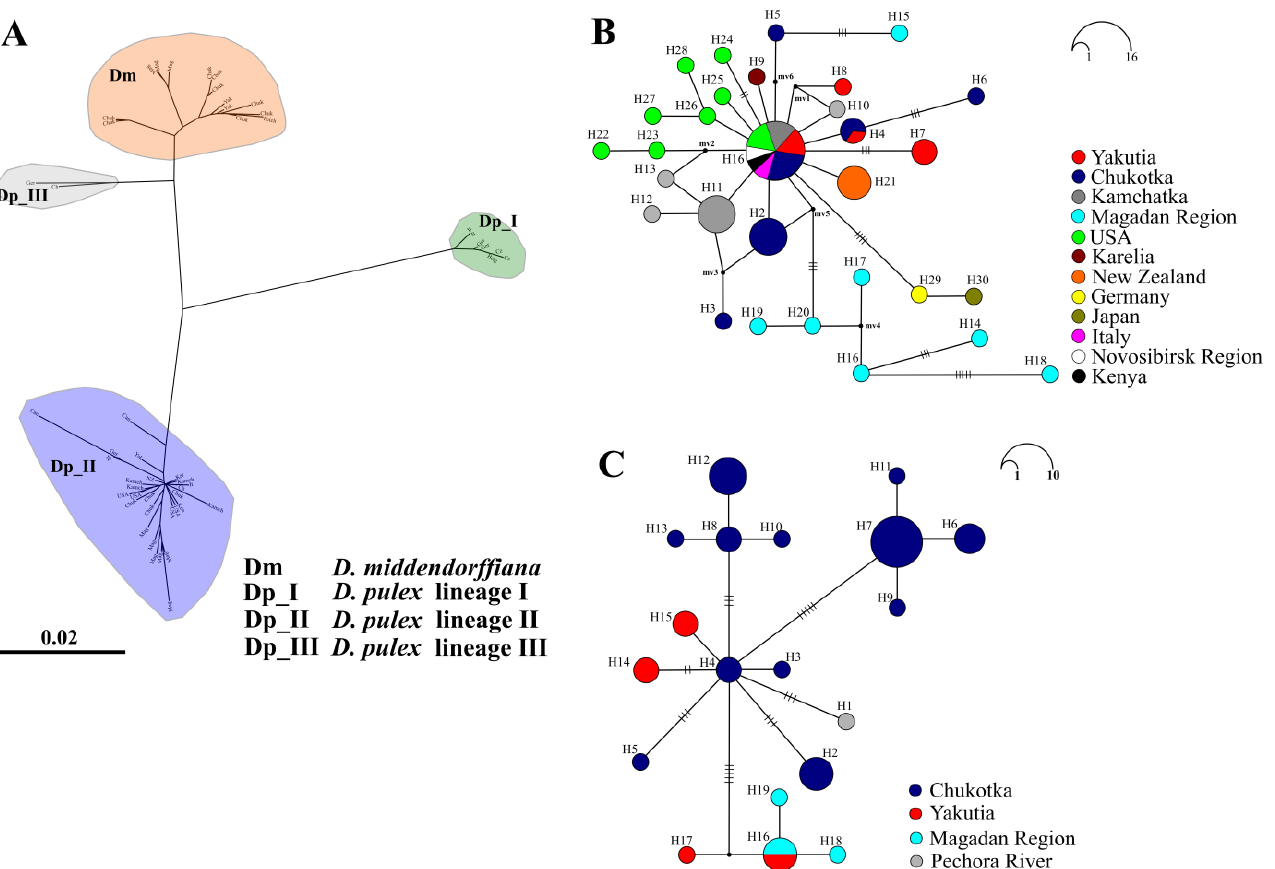
Figure 5. Phylogenetic tree for species of the Daphnia pulex complex reconstructed based on original and obtained from the GenBank database 12S haplotypes ( A ); median-joining networks for Dp_II clade ( B ) and D. middendorffiana clade ( C ). The scale is given in expected substitutions per site.